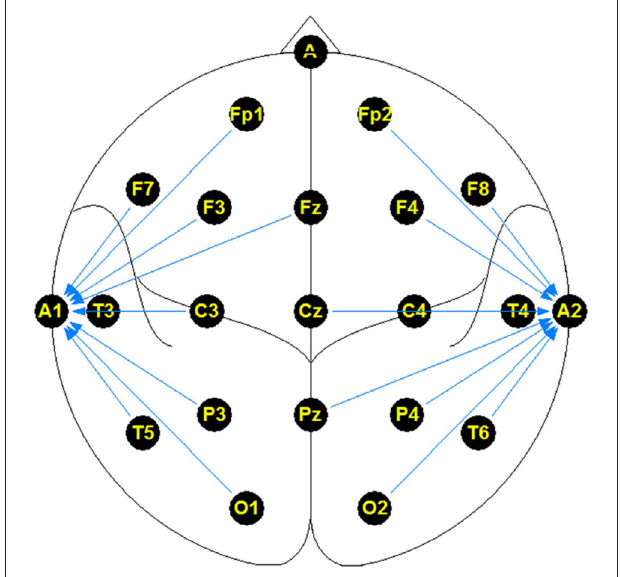
FIGURE 1 | Linked ear referenced standard electrode